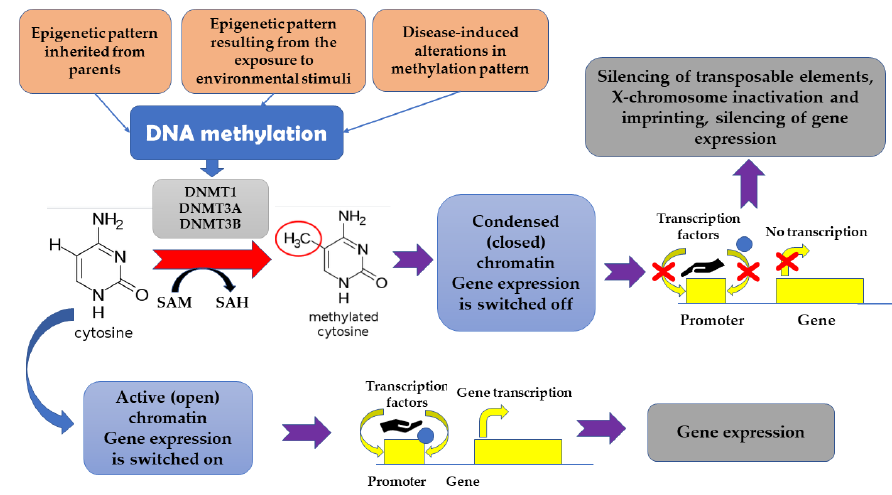
Figure 1. The impact of methylation on gene expression.